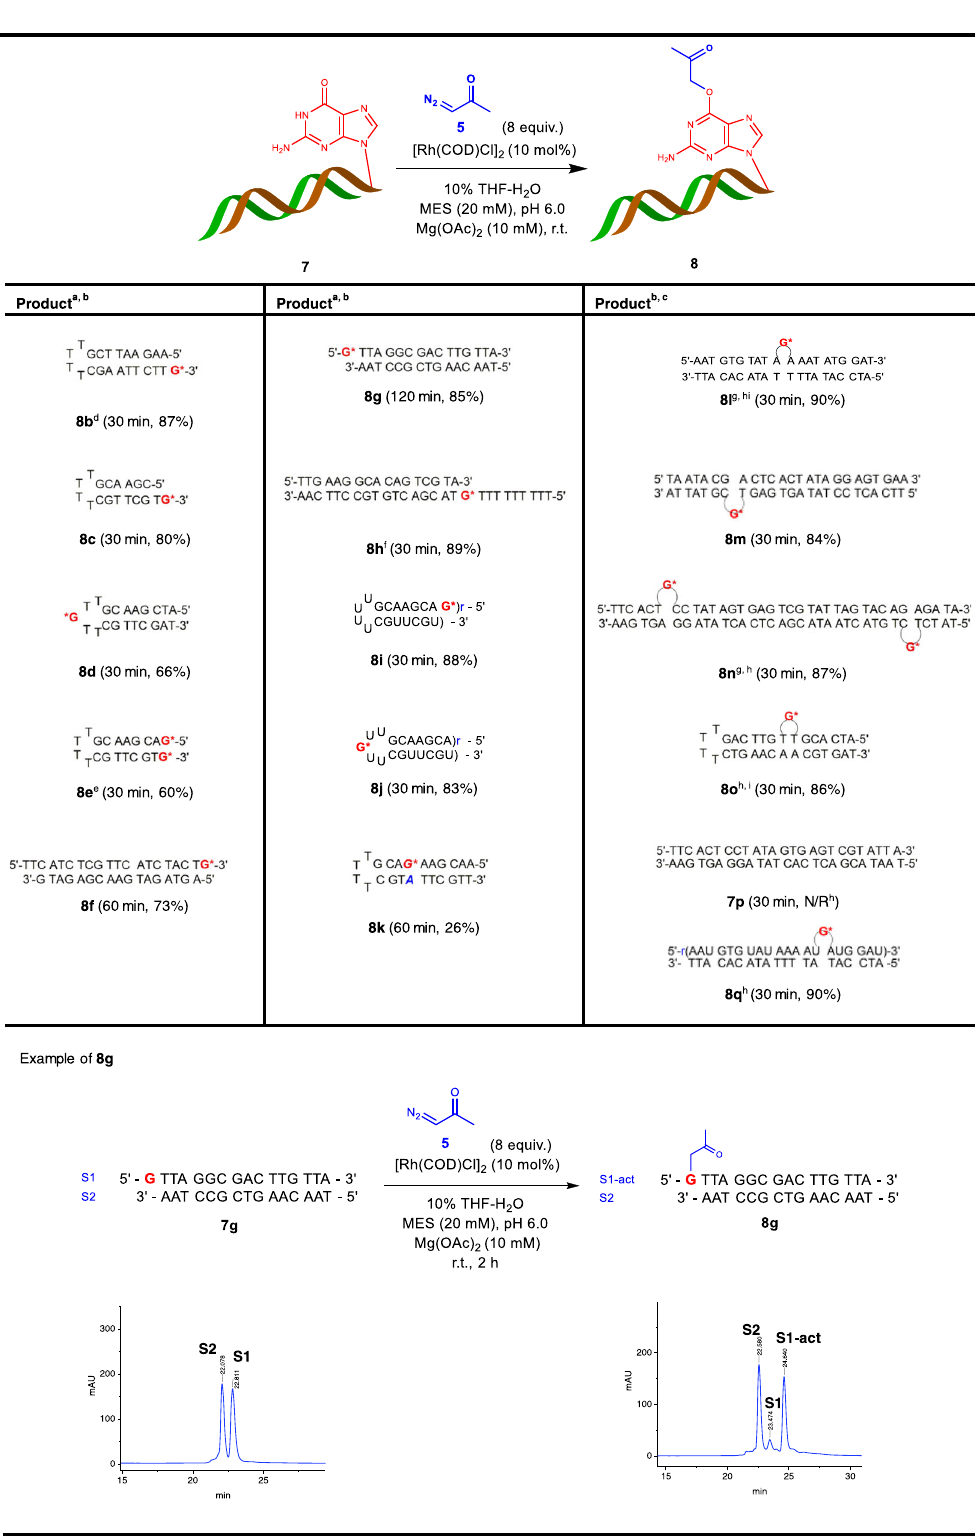
Fig. 5 Scope for hairpins and duplexes. All oligonucleotide (ON)s are oligodeoxynucleotides (ODN)s unless noted as r(sequence). All the reactions were analyzed by HPLC, as exempli fi ed at the bottom of the fi gure. In 8k , mismatched A was marked in blue. a Conditions a: ON (5 mM), diazoacetone (8 equiv.), [Rh(COD)Cl] 2 (10 mol%), 10% THF-H 2 O, MES (20 mM), pH 6.0, Mg(OAc) 2 (10 mM), r.t. b Yield was calculated by HPLC analysis. c Conditions b: ON (5 mM), diazoacetone (100 mM), [Rh(COD)Cl] 2 (10 mol%), 10% THF-H 2 O, MES (50 mM), pH 6.0, Mg(OAc) 2 (50 mM), r.t. d Modi fi cation site was determined by endonuclease digestion (See Fig. 4c, d). e 16 equiv. of diazoacetone, 15 mol% [Rh(COD)Cl] 2 (deviation from Conditions a). f 16 equiv. of diazoacetone (deviation from Conditions b). g 40 equiv. of diazoacetone (deviation from Conditions b). h Yield was calculated after oxime ether conjugation with excess amount of benzyloxyamine. i 12 equiv. of diazoacetone (deviation from Conditions b). N/R = no